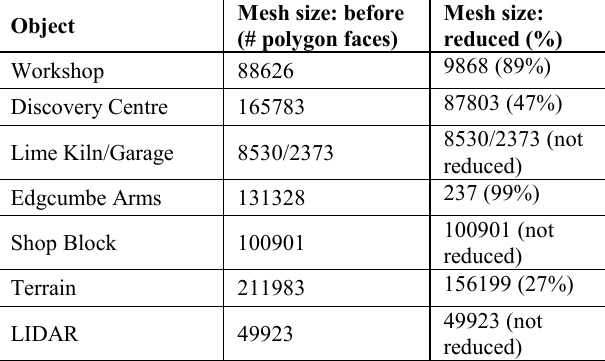
Table 3 Mesh densities (in number of polygon faces) for each object; 3D Rehshaper and reduced mesh size with percentage